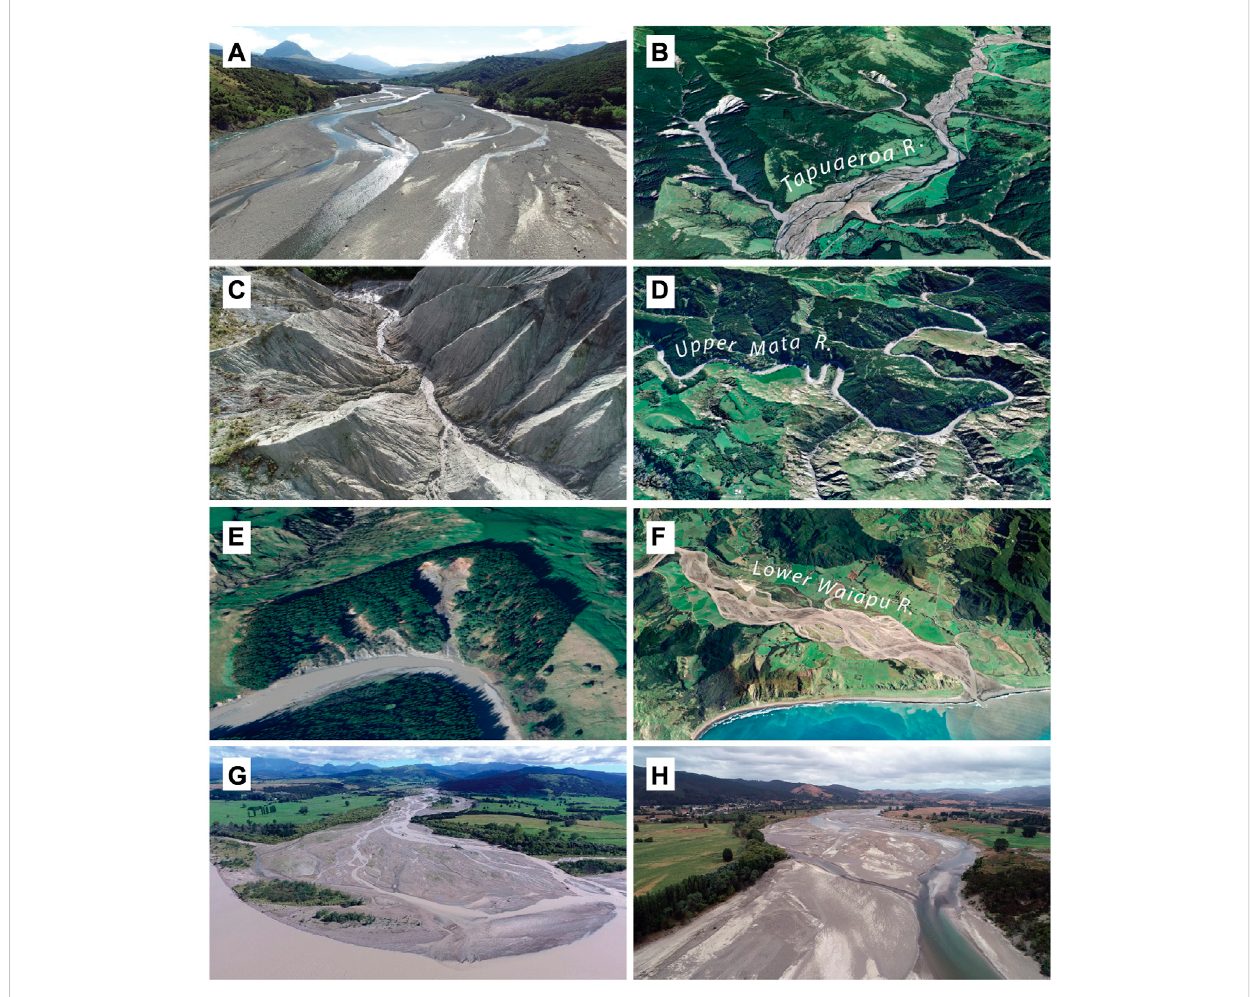
FIGURE 5 Rapid sediment input from gully mass movement complexes following deforestation and subsequent forest management practices has induced dramatic geomorphic adjustment (aggradation) along the Waiapu River. (A) View upstream on the Tapuaeroa River; (B) Oblique view of the Tapuaeroa; the Mangapekeke (at left) and Mokoiwi (upper centre) have several gullies delivering a long-term supply of weathered material to the river network; (C) A view of the ‘ badlands ’ topography within Barton ’ s Gully, one of the largest sediment sources in the catchment; (D) The winding,